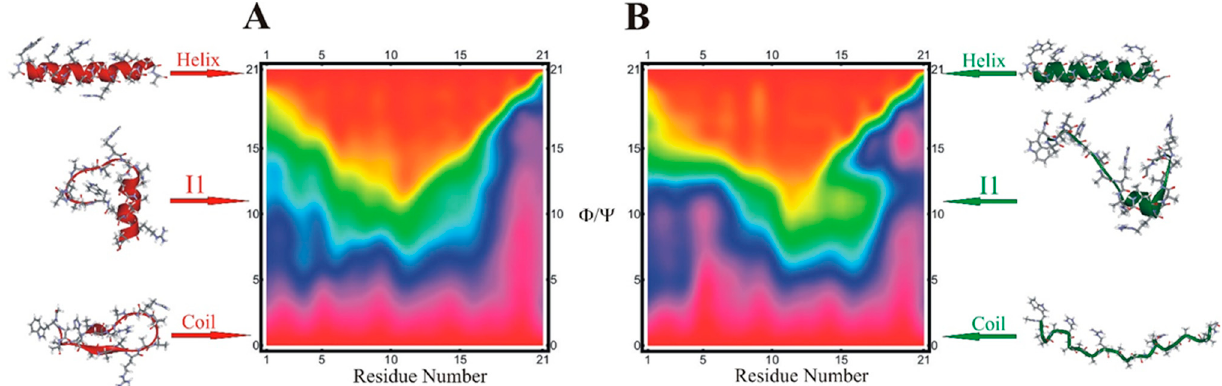
Figure 6. Results of the statistical pathway analysis for the helix–coil transition are shown. Data for the helix populations of individual residues (horizontal axis, NR = 1–21) are averaged over samples of conformations with a given number of residues in the helical region of the Ramachandran plot (vertical axis, NH = 0–21)—i.e., within a 20 o radius of the ideal helix location taken from the final 500 ns of all 40 replicas of replica exchange molecular dynamics. Thus, the bottom row (labeled “0” on the vertical axis) describes structures with NH = 0 helical residues. The top row, labeled “21”, describes structures with all 21 residues in the helical state. The colors encode the average helix population of each peptide residue in the 0–1 range; red—0.0, green—0.5, purple—1.0. The molecular structures are cluster centers for the N = 3 model. ( A ) WH21 0 and ( B ) protonated WH21 + [82].